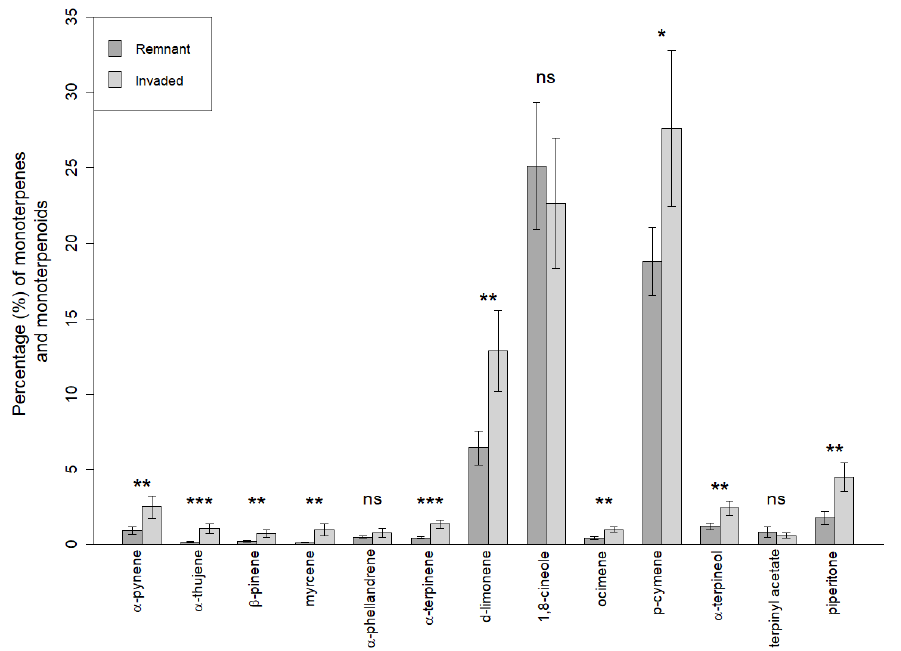
Figure 6. Histogram representing the amount (%) of monoterpenes and monoterpenoids annotated as volatiles collected in remnant area of natural vegetation (R) and areas invaded by P. undulatum (I). Each value is the mean of five measurements ± SD. Error bars indicate standard deviation, and the asterisks indicate significant differences between R and I: ns > 0.05, * 0.01< p < 0.05, ** 0.001< p < 0.01, *** p < 0.001.